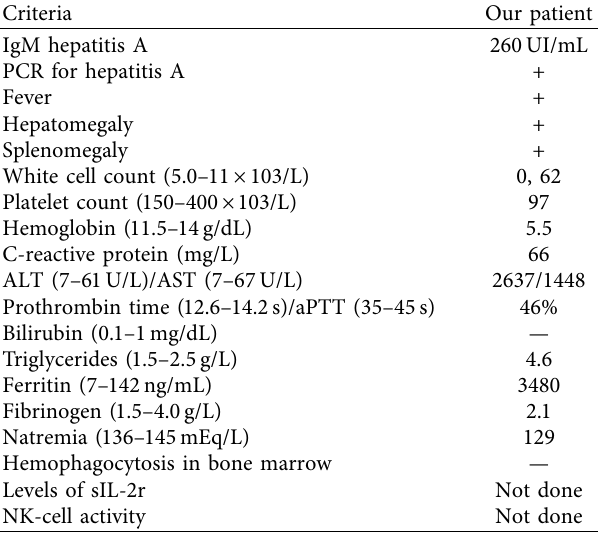
Table 1: Clinical and laboratory fndings of the patient. Criteria Our